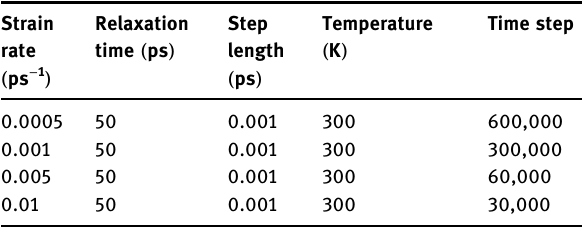
Table 3: Parameter settings under speed variables